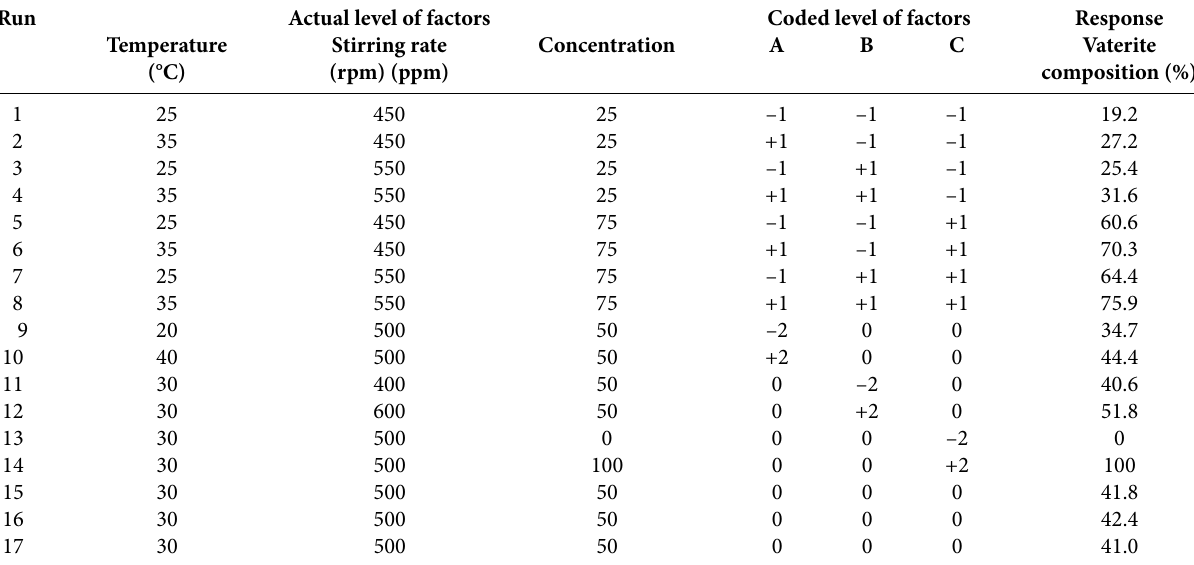
Table 4. Central composite design matrix and results. Run Actual level of